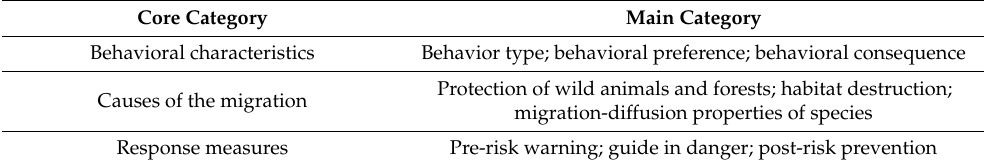
Table 3. Core category.